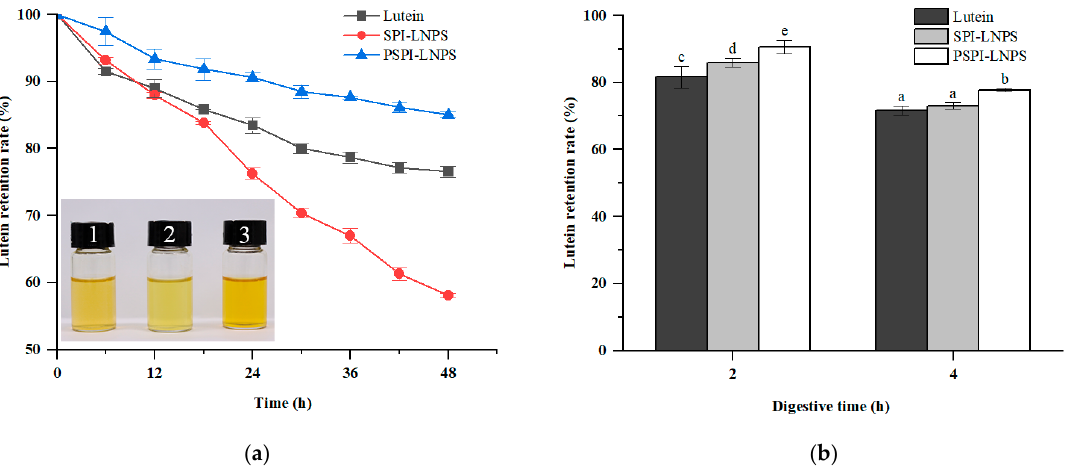
Figure 3. ( a ) Lutein retention rate of unencapsulated lutein, SPI-LNPS, and PSPI-LNPS after 48 h of light exposure; ( b ) Lutein retention rate of unencapsulated lutein, SPI-LNPS, and PSPI-LNPS after 4 h of digestion. Lutein (1), SPI-LNPS (2), and PSPI-LNPS (3) were photographed in ( a ) after 48 h of exposure to light. The standard deviation is represented by the bars. Columns with different letters (a − e) indicate a significant difference between samples ( p < 0.05).